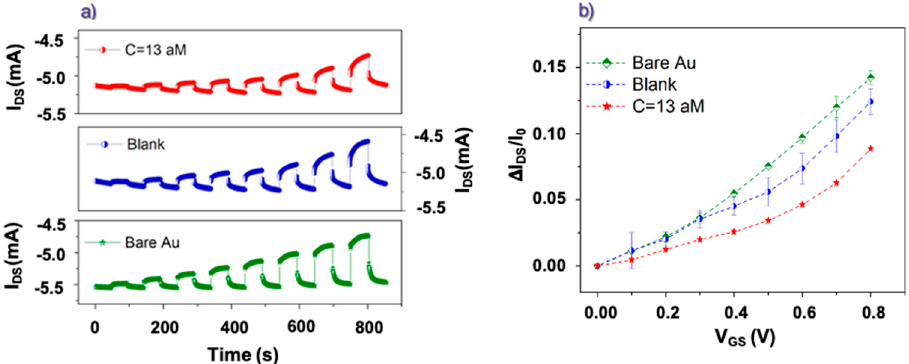
Figure 2. ( a ) I DS vs. time (pulse) curves recorded in PBS using a pristine gate electrode (Bare Au), a gate electrode functionalized with anti-TG2 antibodies before any incubation step (Blank) and after the incubation in solution with attomolar concentration of rhTG2 protein (C = 13 aM). ( b ) Corresponding average values of the I DS modulation extracted as a function of V GS . Error bars represent the standard deviations.